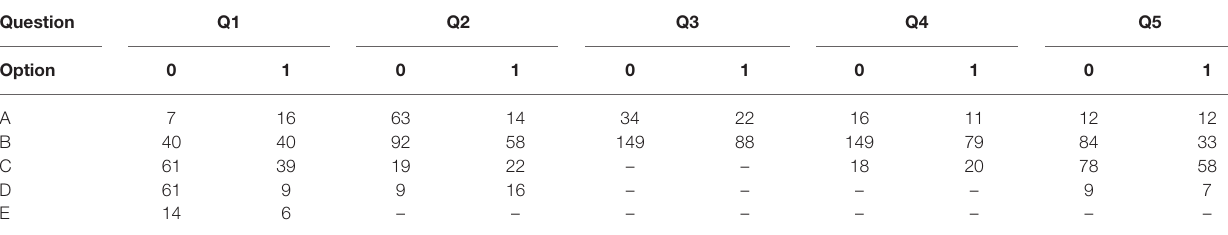
TABLE 8 | Cross-tab statistics of the Q1–Q5 questionnaires.